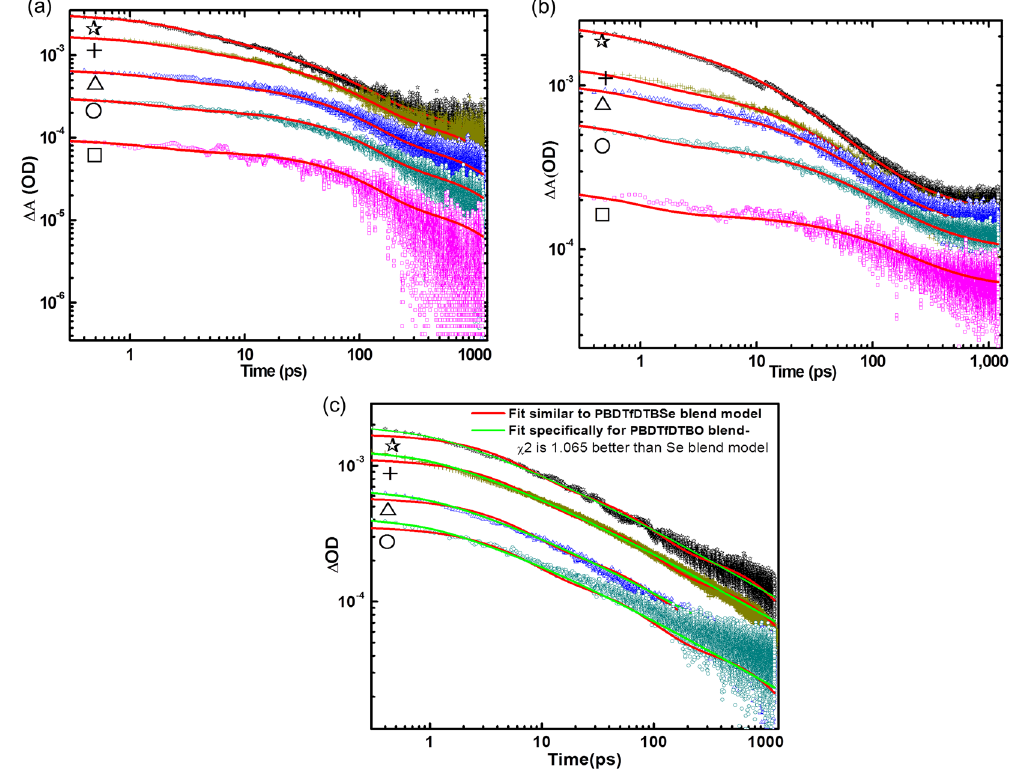
Figure 3. Intensity dependences of the transient absorption kinetics of the (a) PBDTfDTBT:PC[70]BM (1:1.5) and (b) PBDTfDTBSe:PC[70]BM (1:1) blends at various excitation fluence (ph/cm 2 /pulse). The fluences are color coded as follows: 2.8 × 10 14 (black, ☆ ), 9.4 × 10 13 (dark yellow, + ), 5.7 × 10 13 (blue, Δ ), 2.8 × 10 13 (dark cyan, ○ ), 9.4 × 10 12 (magenta, □ ). (c) PBDTfDTBO:PC[70]BM (1:1) blend at various excitation fluence (ph/cm 2 /pulse). The fluences are color-coded as follows: 3.6 × 10 14 (black, ☆ ), 1.23 × 10 14 (dark yellow, + ), 6.15 × 10 13 (blue, Δ ), 3.69 × 10 13 (dark cyan, ○ ). Fitting in green is performed specifically for the results for the PBDTfDTBO:PC[70]BM (1:1) blend. The red fits shows the fitting results obtained for the PBDTfDTBO:PC[70] BM (1:1) blend with the model used for the other two